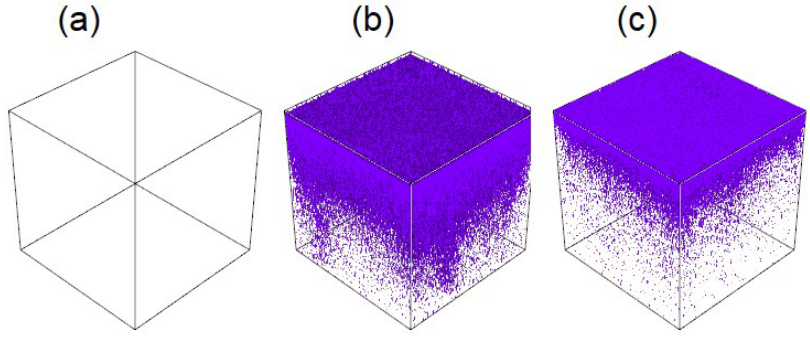
Figure 6. Reconstructed 3D negative-ion (ZnS − ) depth-profiling images of hemimorphite samples treated with ( a ) deionized water, ( b ) 5 mM Na 2 S, and ( c ) 5 mM Na 2 S and 1mM Fe 3+ .